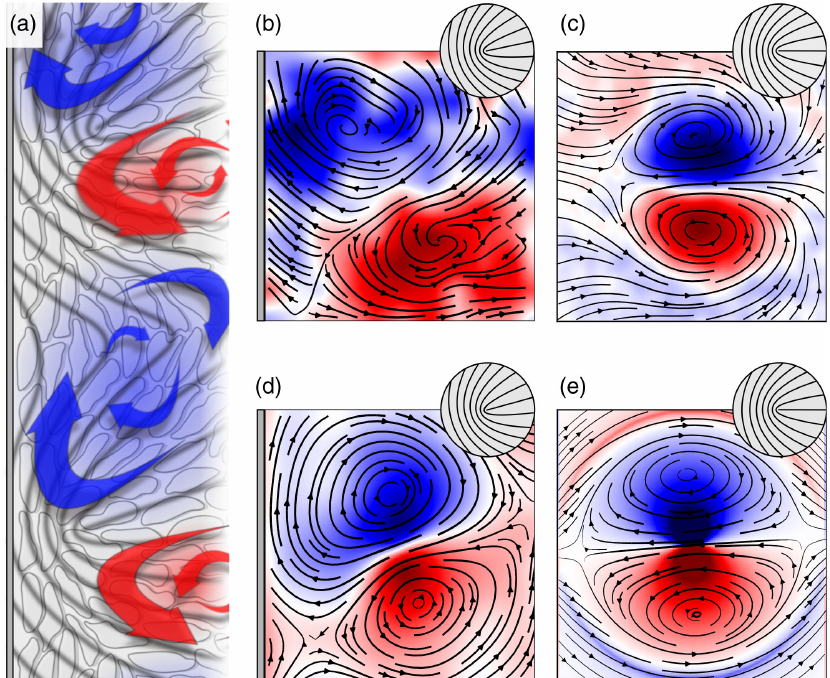
FIG. 2. (a) Schematic of the hypothesized behavior of defects close to the boundary. Motion of þ 1 = 2 defects and elastic interactions lead to an accumulation of defects aligned quasiperpendicular to the left boundary. The chiral activity leads to a net flow along the boundary. (b) Average flow around 56 729 þ 1 = 2 defects in a HT1080 monolayer close to the boundary (gray line) with a chiral tilt of 32.5° relative to the defect orientation (inset). (c) Average flow around 143 185 þ 1 = 2 defects in a HT1080 monolayer far from the boundary with a chiral tilt of 3.4° relative to the defect orientation (inset). (d) Average flow around þ 1 = 2 defects made over 10 6 time steps in a simulated chiral active nematic ( α ¼ − 10 . 0 , τ ¼ − 1 . 25 ) close to the left boundary (gray line). This shows a tilt relative to the average defect orientation (inset). (e) Stokeslet-like flow around an isolated chiral active þ 1 = 2 defect recreating tilt of 3.4° ( τ ¼ 0 . 03 α ) relative to the defect orientation (inset). Dimensions in (b) and (c) correspond to 250 × 250 μ m 2